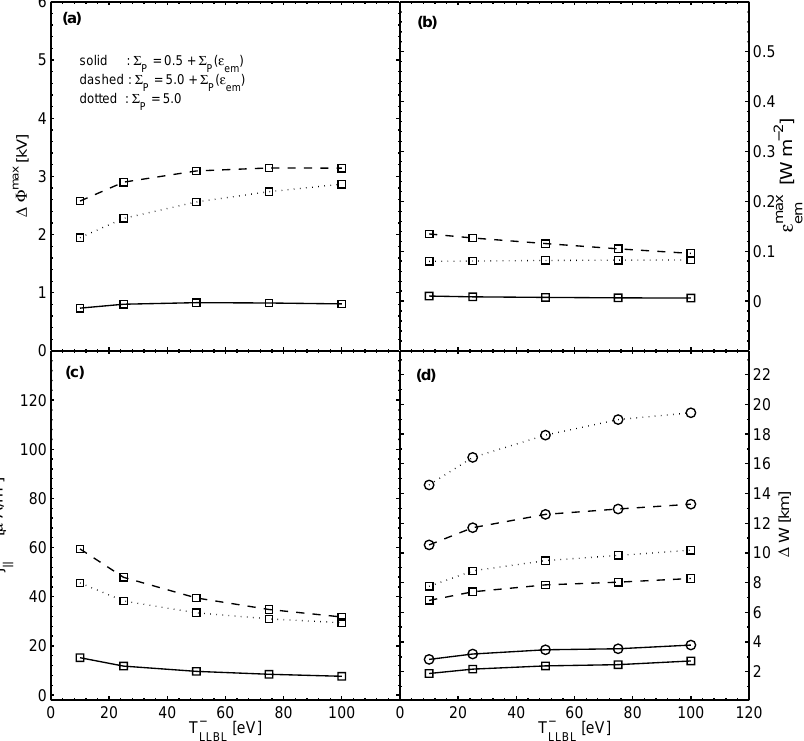
Fig. 10. Auroral arc’s characteristics as a function of: (a) the LLBL electron temperature and (b) the height-integrated Pedersen conductivity. Solid lines represents results obtained for a 6 P that depends on (cid:15) em (see Eq. 2) with a background conductance 6 P 0 = 0 . 5; dashed lines show results obtained for a non-uniform conductance with 6 P 0 = 5 . 0S; dotted lines correspond to results obtained for a uniform Pedersen conductance, 6 P = 5S. Same scales are used as in Fig. 6 for a better comparison of the results. See also caption of Fig. 6 for a description of panel